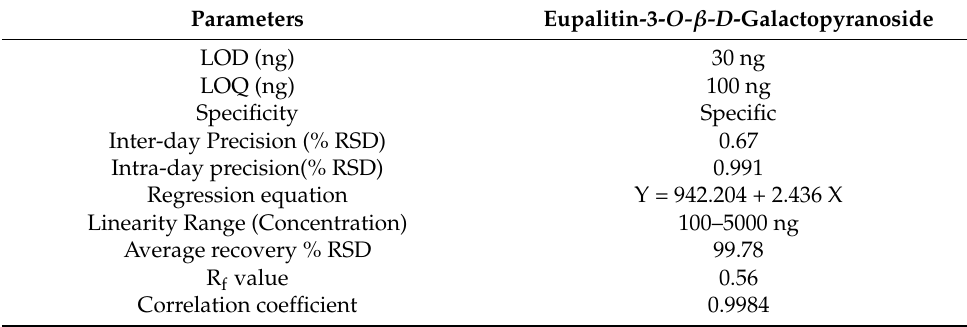
Table 1. Method validation parameters of eupalitin-3- O- β -D -galactopyranoside.